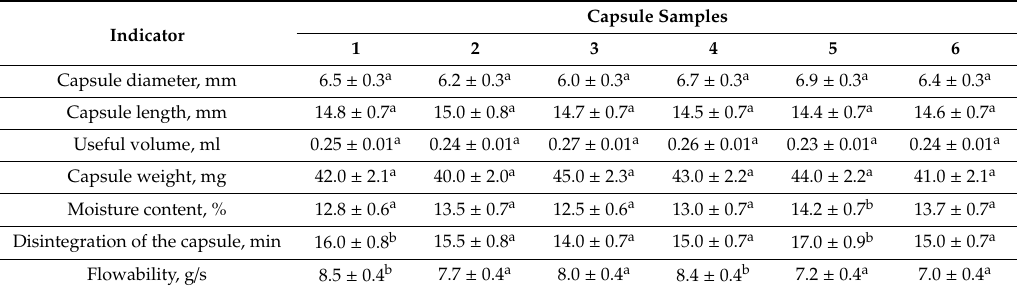
Table 2. Physicochemical properties of capsules based on plant